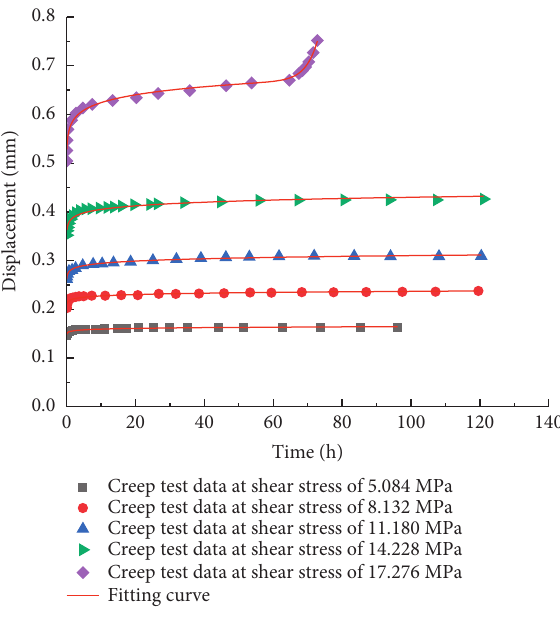
Figure 6: Test data and fitting curve.